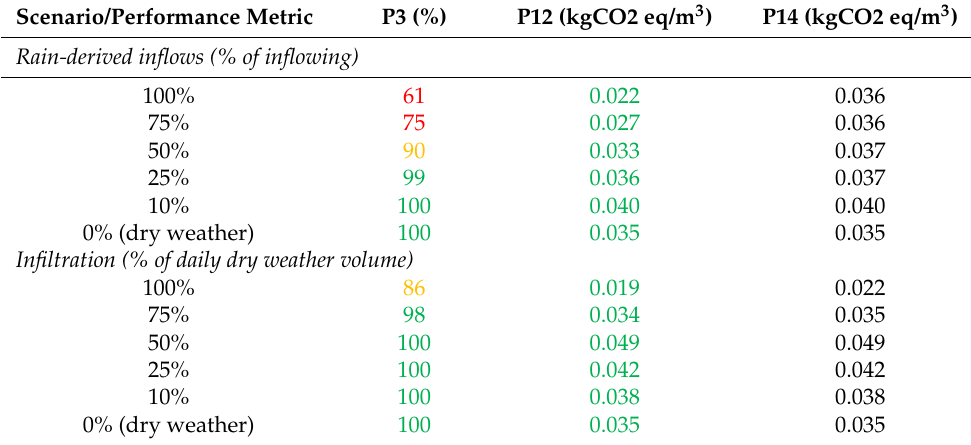
Table 3. Results for P3, P12, and P14 performance metrics for the subsystem level. Scenario/Performance